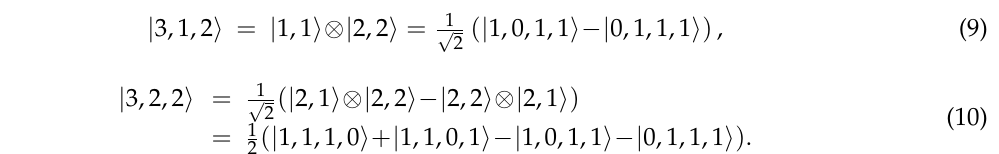
, S 12 , S 34 (cid:105) are specified according T , as well T